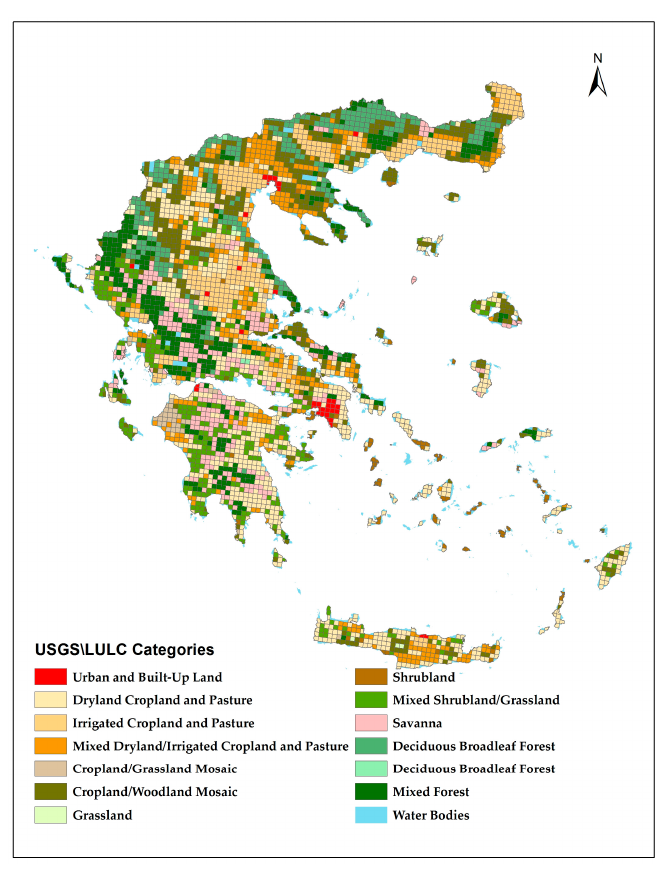
Figure 1. Greece with the land-use categories attributed at each cell with a spatial resolution of 6 × 6 km 2